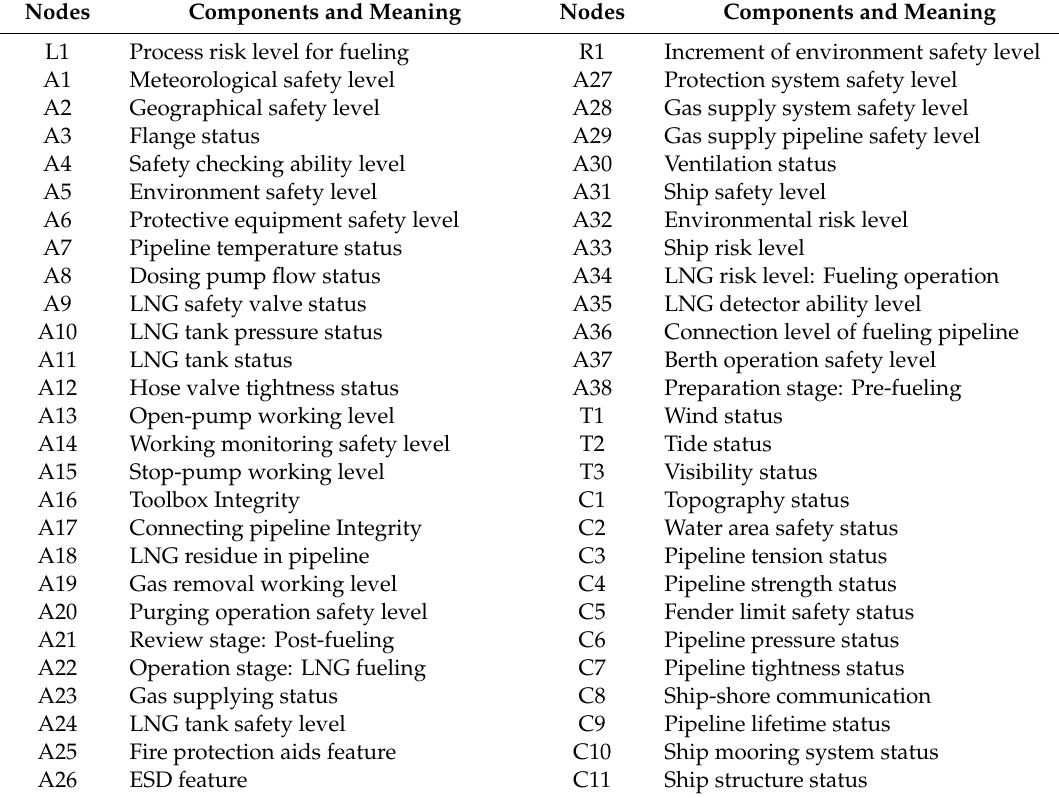
Nodes Components and Meaning